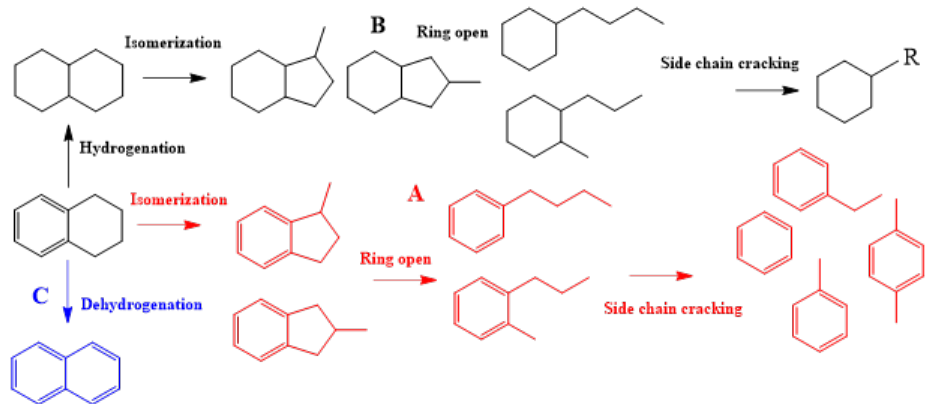
Figure 6. Reaction scheme for tetralin hydrocracking over bifunctional catalysts. A: Isomerization- cracking; B: hydrogenation-cracking; and C: dehydrogenation.